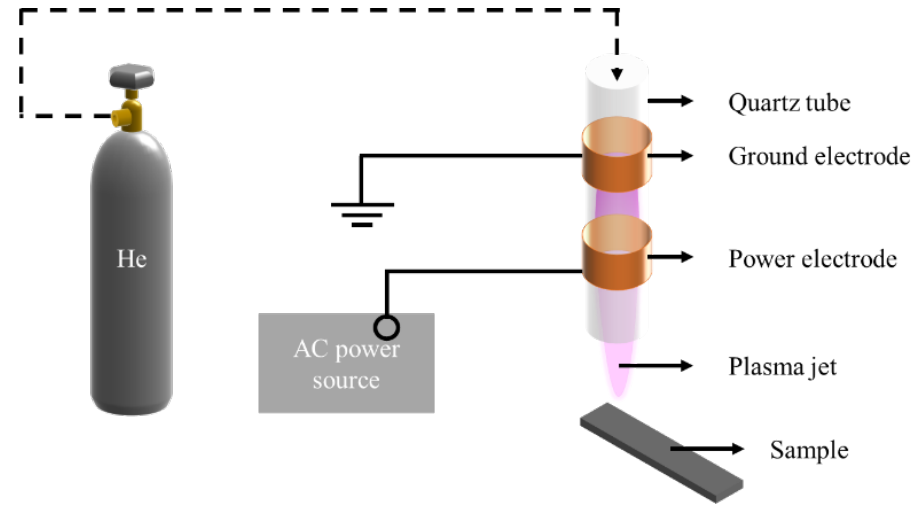
Figure 1. Schematic of the He-DBD jet.